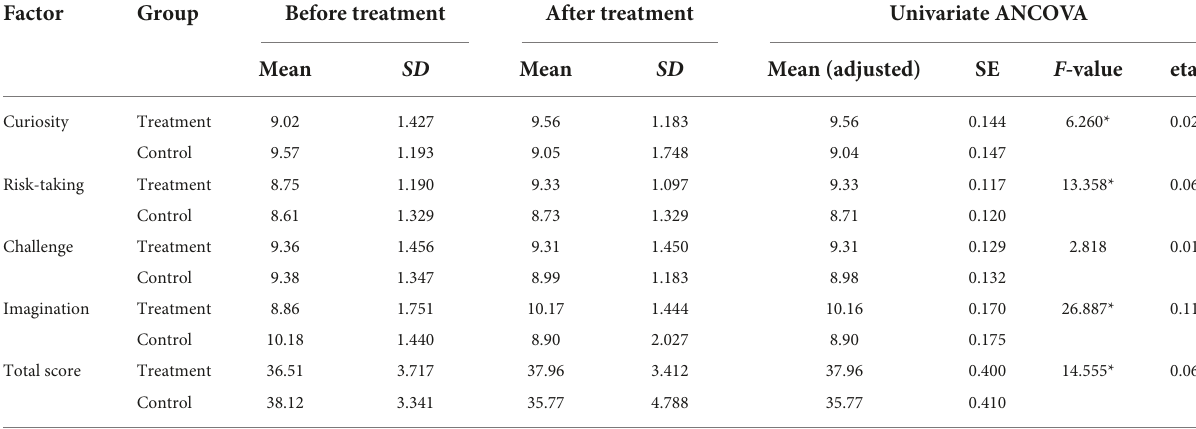
TABLE 4 Descriptive statistics of students’ pretest and posttest scores and ANCOVA summary of